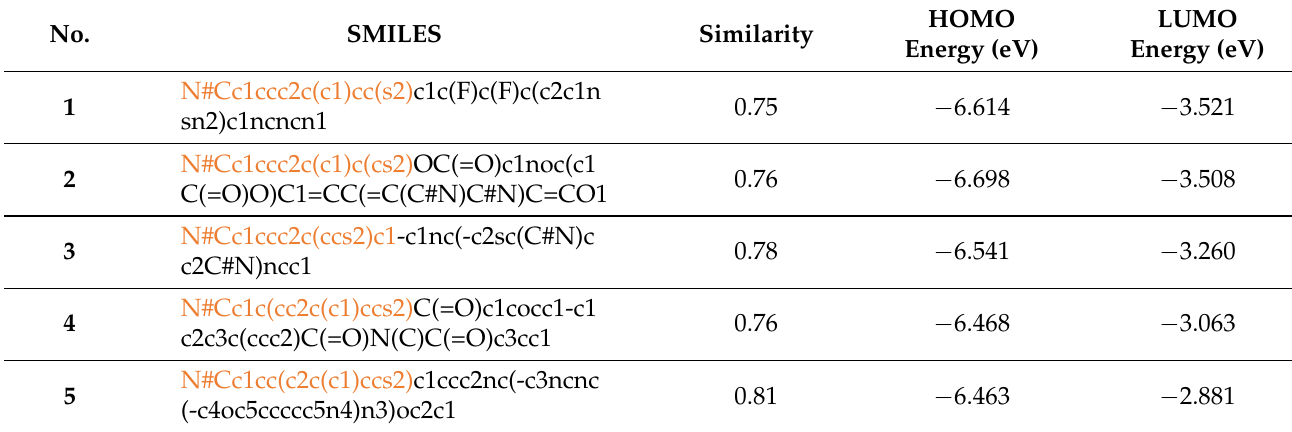
Table 1. The SMILES strings and predicted HOMO and LUMO energies of five generated molecules.